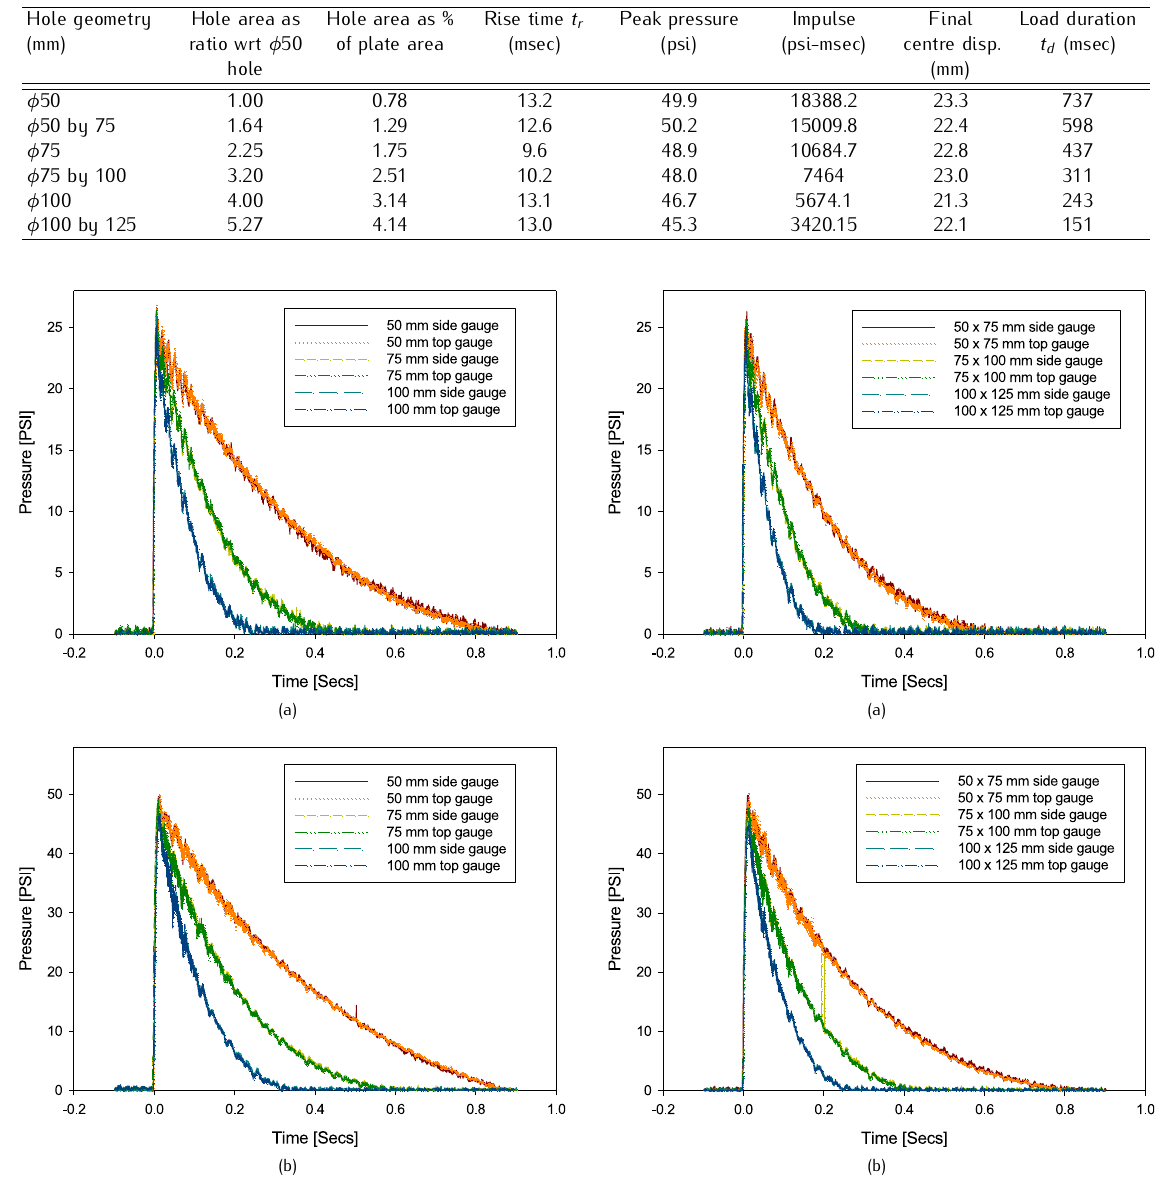
Table 3. Test data for square plates with circular holes loaded to nominally 50 psi.